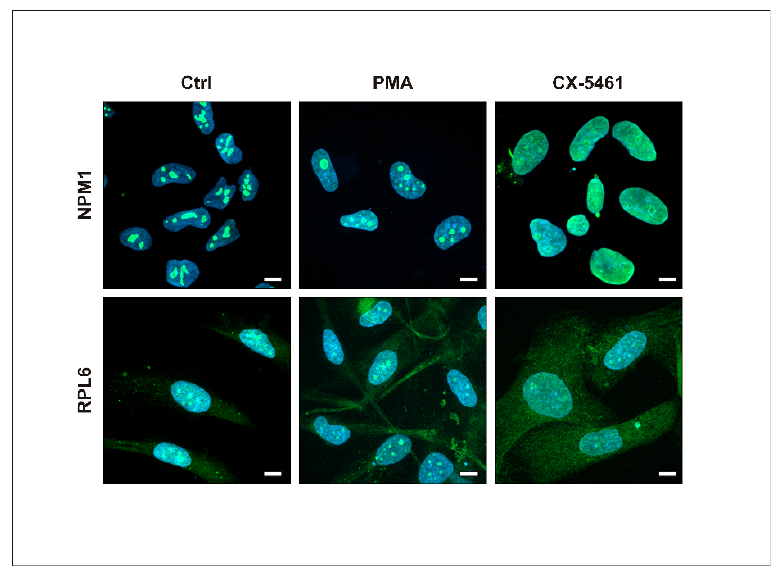
Figure 2. Assessment of nucleolar integrity of MO3.13 cells. Control cells (Ctrl) and cells treated with PMA or CX-5461. Representative images after staining with specific antibodies against NPM1 (green, upper panel) and RPL6 (green, lower panel) and DAPI (cyan, both panels). Scale bar is 10 µm.